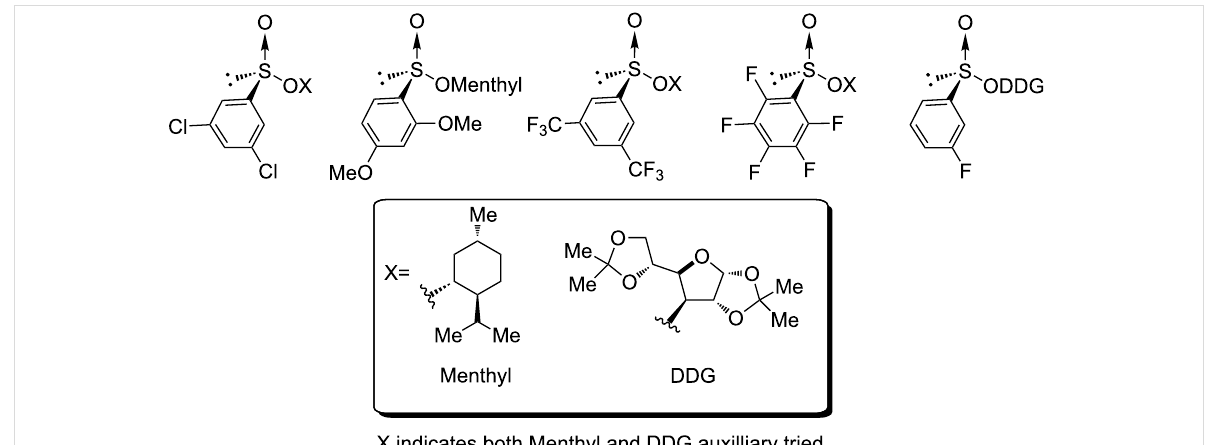
Figure 2: Failed sulfinate ester syntheses.